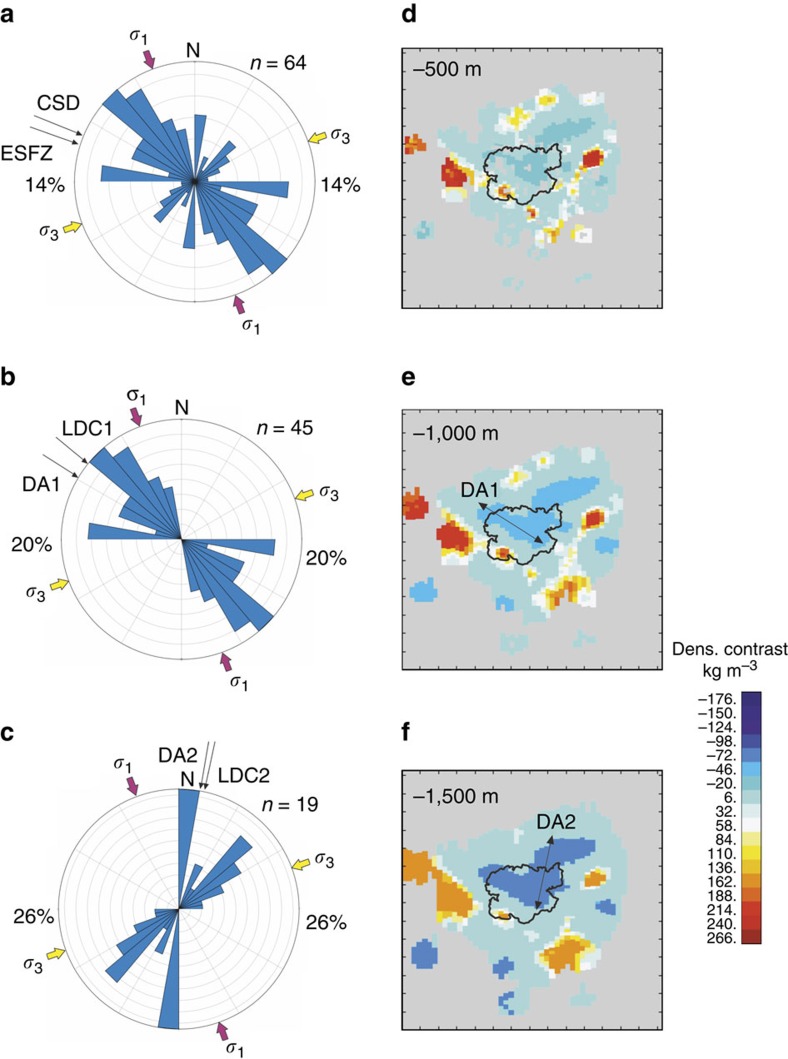
Rose diagrams and horizontal cross sections of inverse model.(a–c) Rose diagrams of local fault strikes. Arrows indicate trends of other proximal structural and density features as well as approximate principal horizontal compressive stress orientations after11, obtained to the East of Ilopango caldera. (a) All faults1617. (b) NW-SE trending faults. (c) Extraction of N-S and NE-SW trending faults to examine these fault sets in detail. (d–f) Horizontal cross sections through the adjusted ±100 kg m−3 subsurface density model at depths z=−500 (d) z=−1,000 (e) and z=−1,500 m (f), respectively. The outline of Lake Ilopango is shown for reference. Spacing of tick marks on all axes is 3,000 m. CSD, strike of Cocos subduction zone; DA1, NW-SE intra-caldera limb of density anomaly; DA2=NNE-SSW limb of density anomaly; ESFZ, strike of El Salvador Fault Zone; LDC1, orientation of main lava dome chain; LDC2, orientation of north-south lava dome chain.